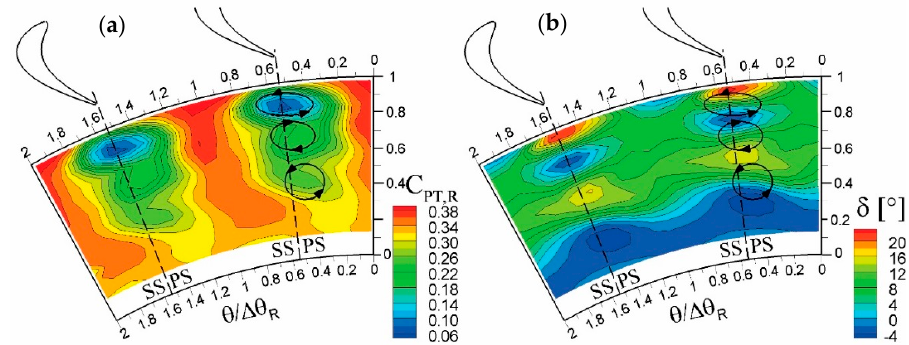
Figure 8. Rotor-exit relative flow field in OP2, ( a ) relative total pressure coefficient; ( b ) deviation angle.